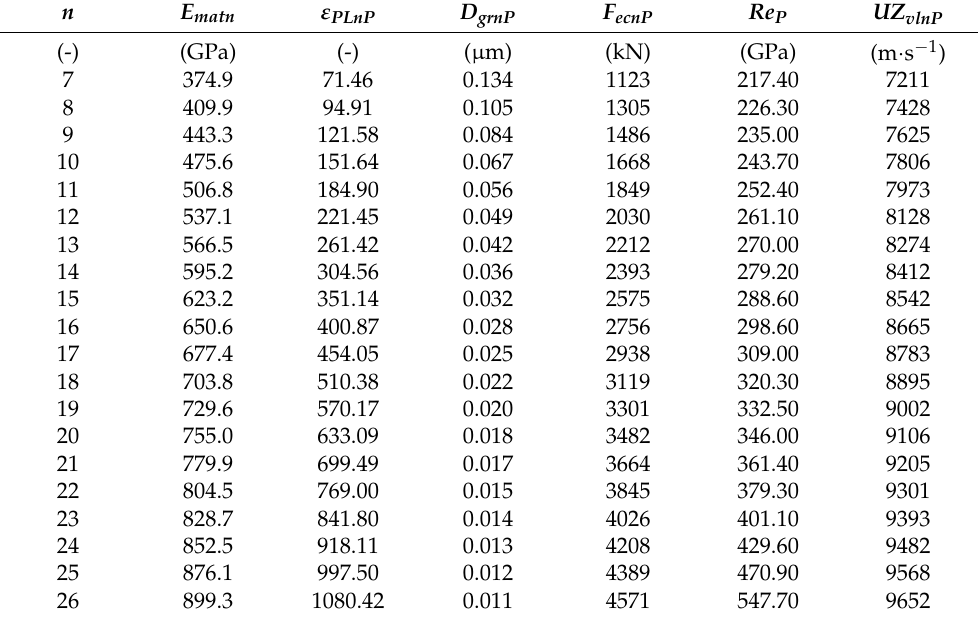
Table 2. Selected predicted parameters for n = (cid:104) 7–26 (cid:105)